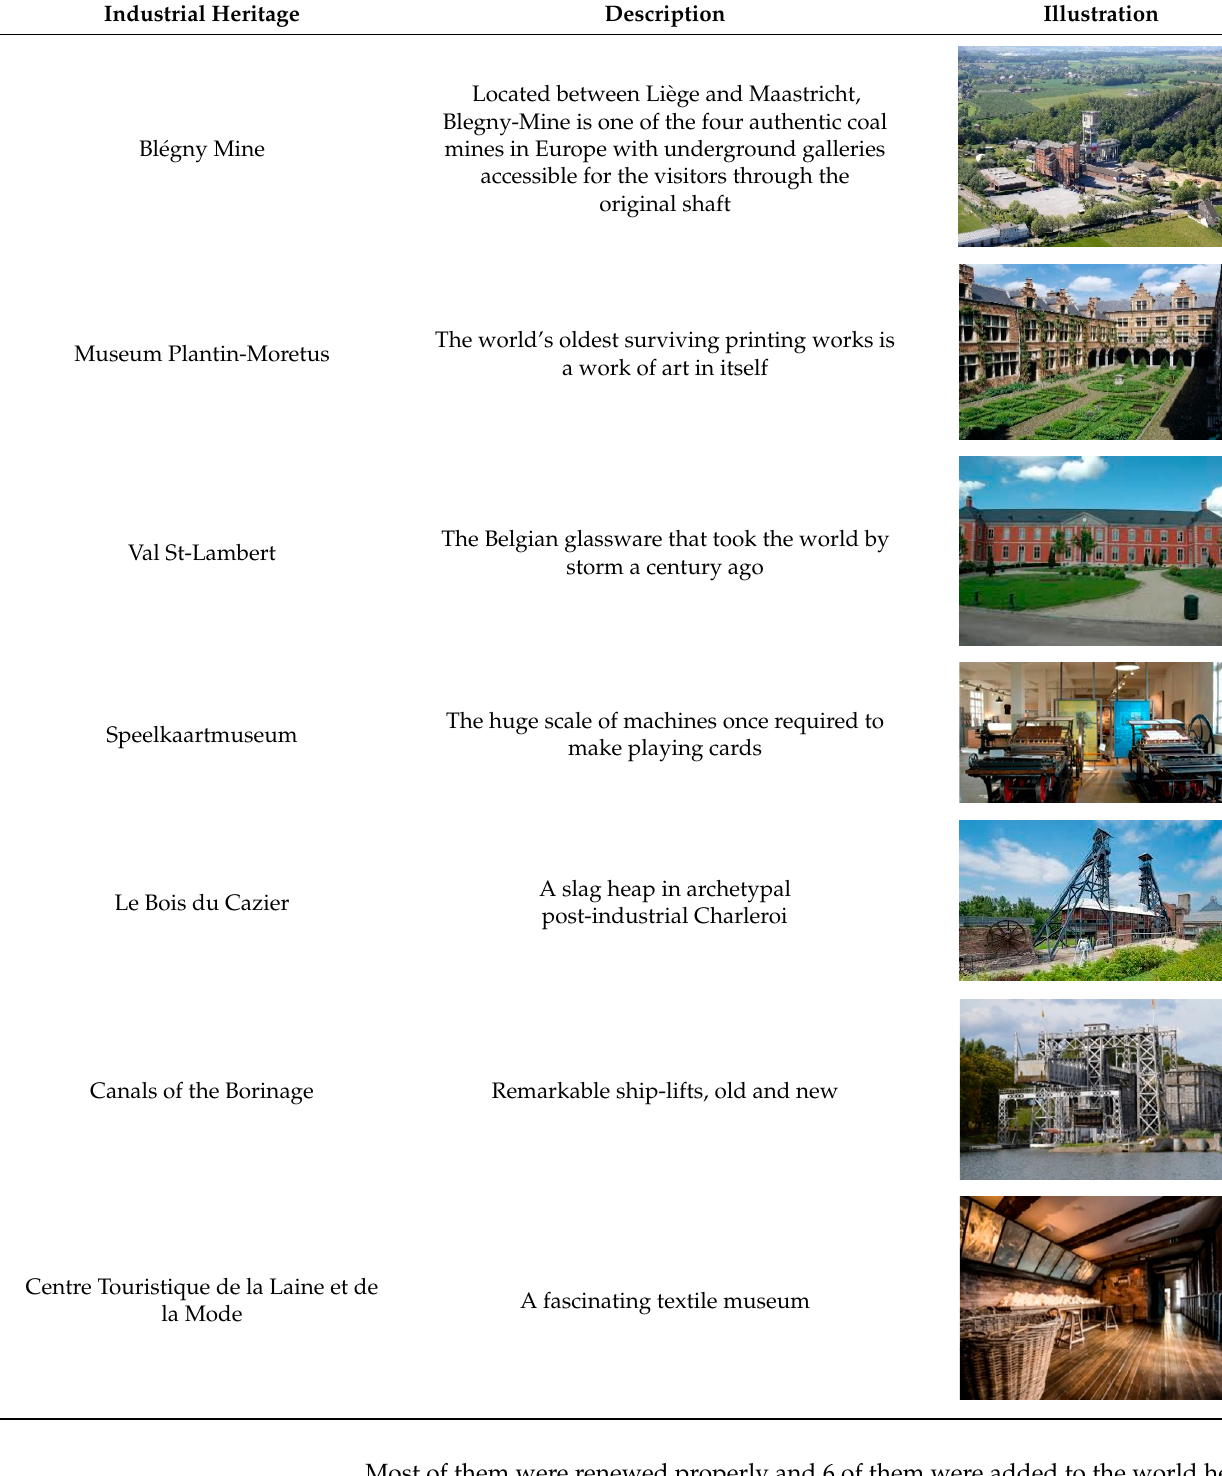
Table 4. Main elements of the Belgian industrial heritage.